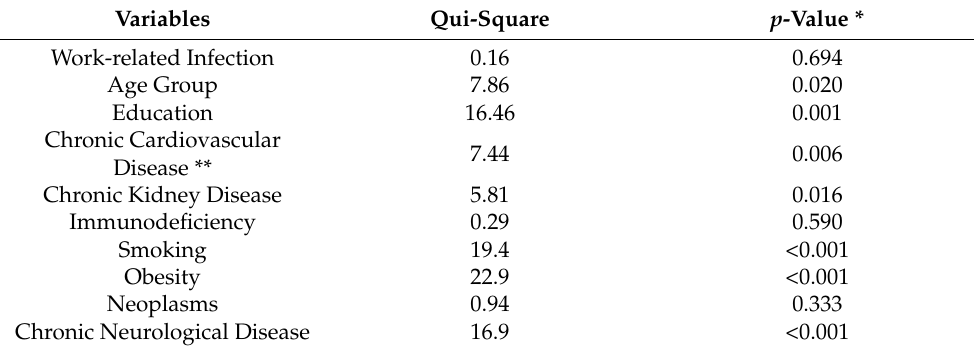
Table 3. Assessment of the risk proportionality assumption by the Cox